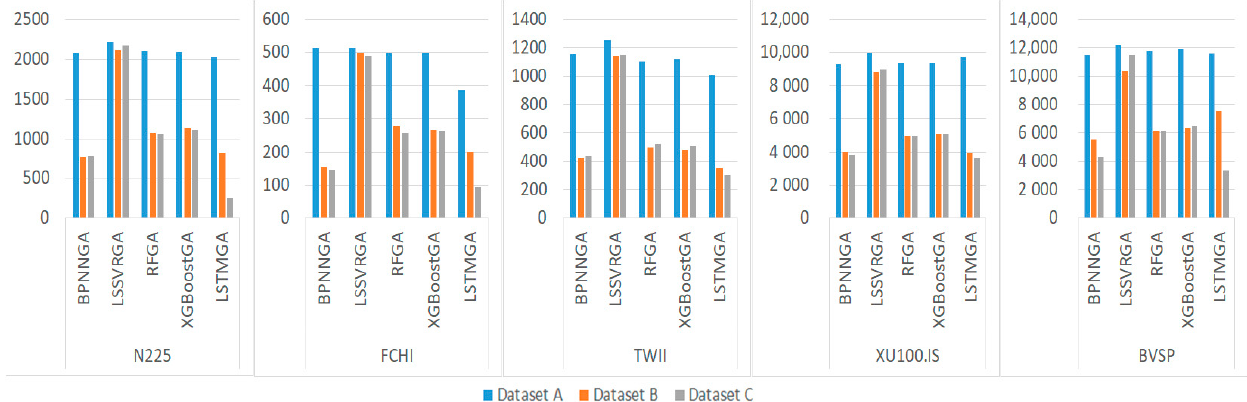
Figure 4. MAPE values of forecasting models for stock market indices with different datasets.